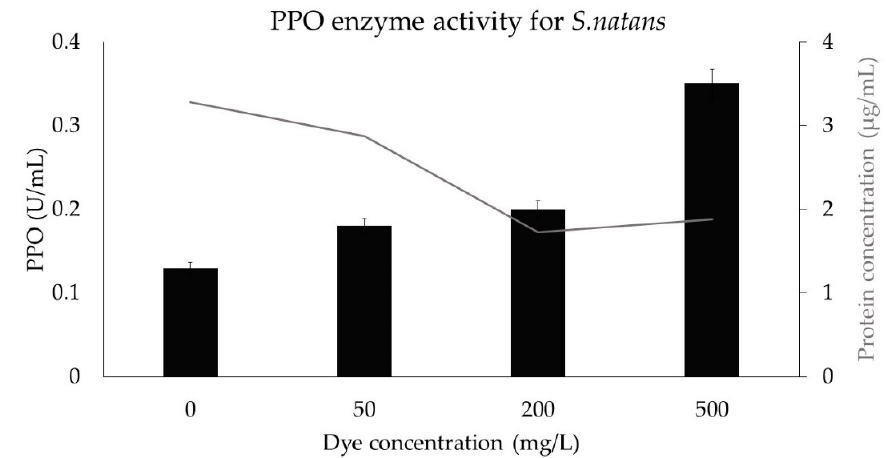
Figure 9. PPO enzyme activity and concentration change of protein for S.natans at different initial dye concentrations after phytoremediation.